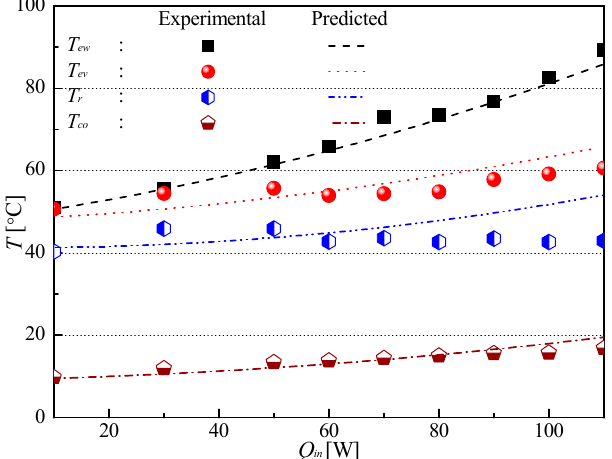
Figure 10. Comparison between experimental and analytical results concerning typical temperatures at horizontal alignment.